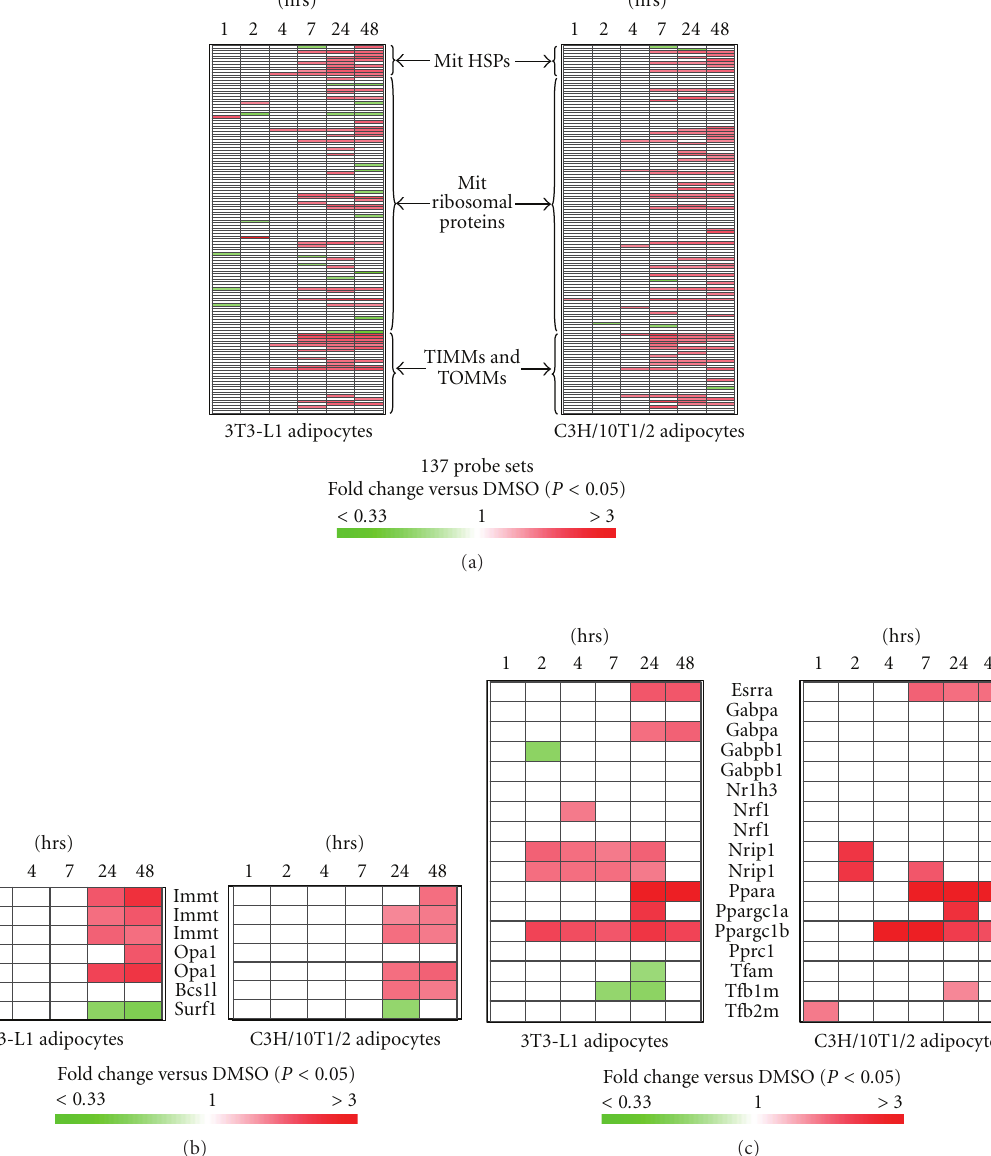
Figure 3: Transcriptional regulation of mitochondrial ribosomal proteins, TIMMs and TOMMs, HSPs (a), structural proteins (b), and transcription factors (c). Shown is a heatmap of mean fold changes of probe set intensities in 3T3-L1 and C3H/10T1/2 adipocytes treated with RSG compared to DMSO over time ( n = 3 per time point in each cell type). Each row represents one probe set. Certain genes were represented by more than one probe set as indicated. Only fold changes significantly di ff erent ( P < 0 . 05) were shown in colors (red or